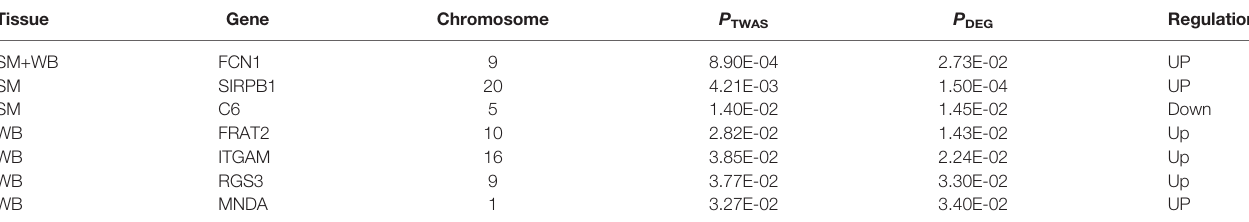
comparing the Metascape results of TWAS analysis and mRNA expression pro fi les, 19 terms were identi fi ed, such as rheumatoid arthritis (hsa05323) and cytokine signaling in immune system (R-HSA-1280215) ( Supplementary Table 5 ).